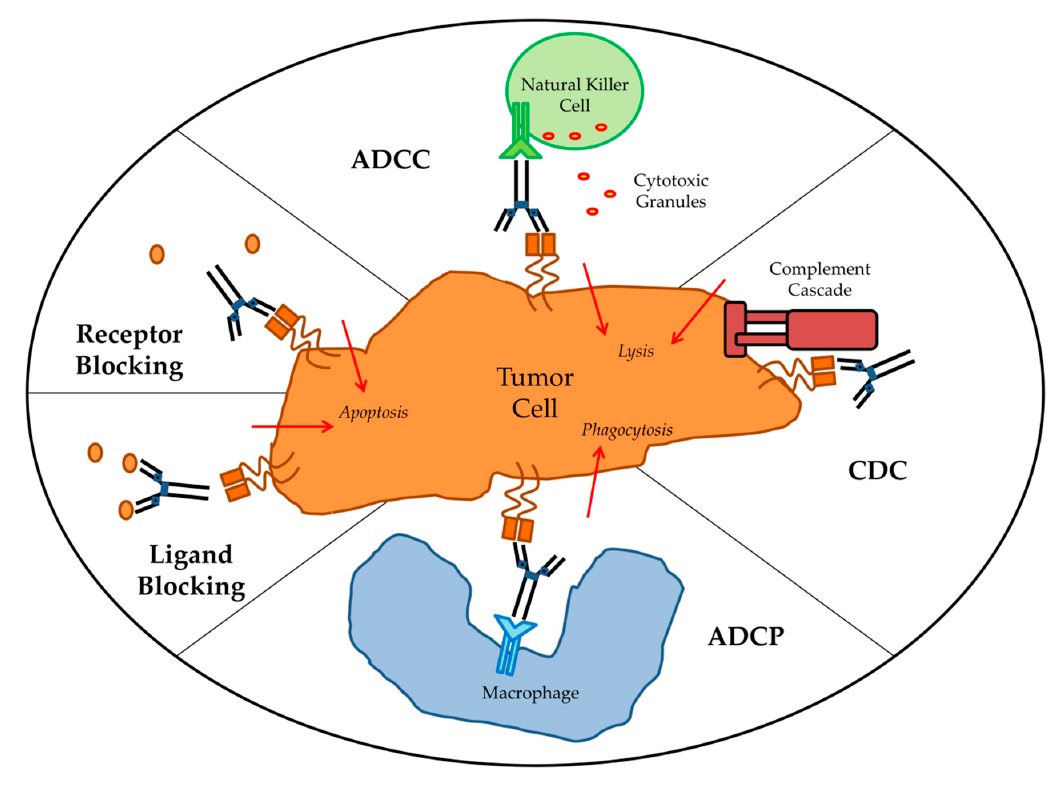
Figure 1. Antibody effector mechanisms. ADCC: antibody-dependent cellular cytotoxicity; CDC: complement-dependent cytotoxicity; ADCP: antibody-dependent cellular phagocytosis.